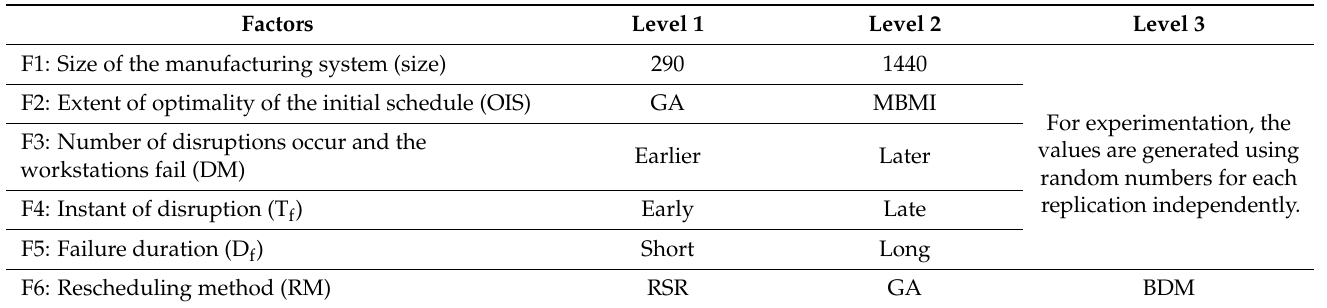
Table 3. Levels of rescheduling factors.